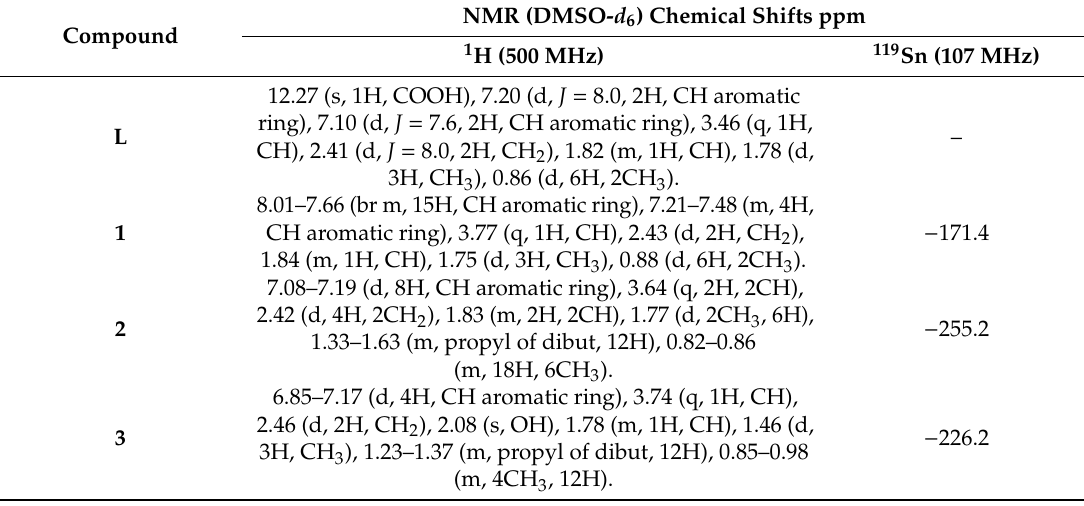
Table 3. 1 H and 119 Sn NMR spectral data for tin